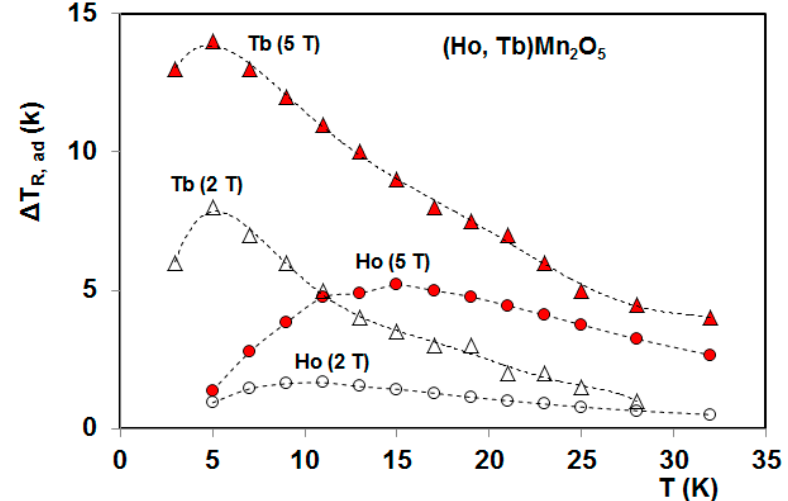
Figure 17. Rotating adiabatic temperature change as a function of temperature for RMn 2 O 5 (R = Ho and Tb) single crystals in constant magnetic fields of 2 and 5 T [19,20]. The crystals are rotated by an angle of 90° around their intermediate axes with magnetic fields initially parallel to the hard-axis.